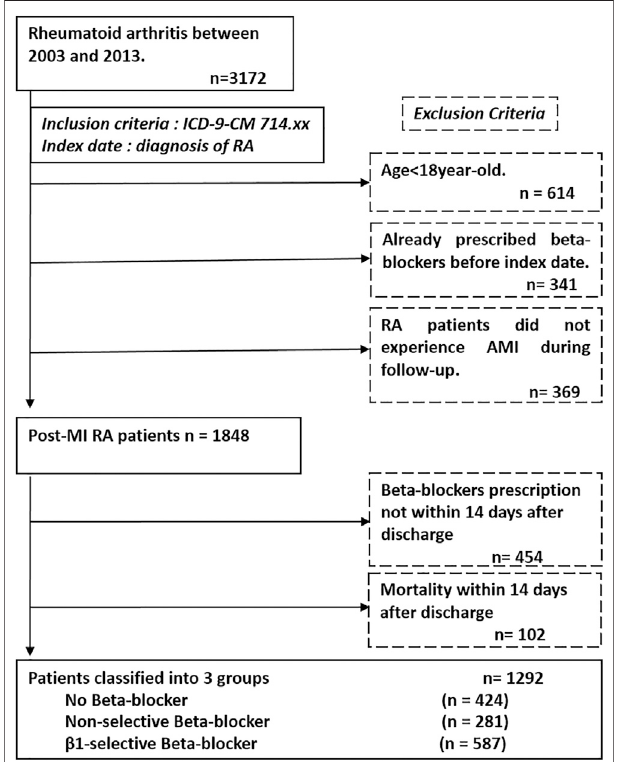
FIGURE1| Patient fl owdiagram. Weenrolled patients from theNational Health Insurance database and identi fi ed subjects with diagnosis of rheumatoid arthritis (ICD-9-CM 714.xx) from 2003 to 2013. The index date of our study was de fi ned as the date of diagnosis of rheumatoid arthritis. The exclusion criteria are listed in the dash line box, which are age < 18 years, already prescribed beta-blockers before index date, not experienced myocardialinfarction duringfollow-up,withoutbeta-blockersprescriptionand incidence of death within 14 days after discharge from hospitalization of myocardial infarction.; Abbreviation: ICD-9-CM, International Classi fi cation of Diseases Ninth Revision Clinical Modi fi cation.